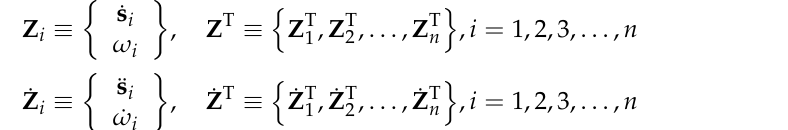
where ω denotes the angular velocity, and n denotes the number of bodies excluding the fixed body, which equals 20 in this